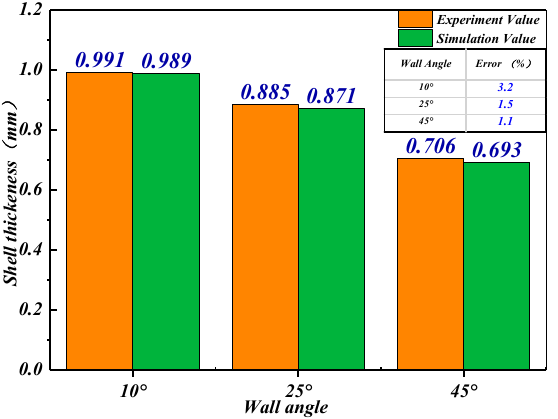
Figure 4. Comparison of the experiment and the simulation value of wall thickness error.